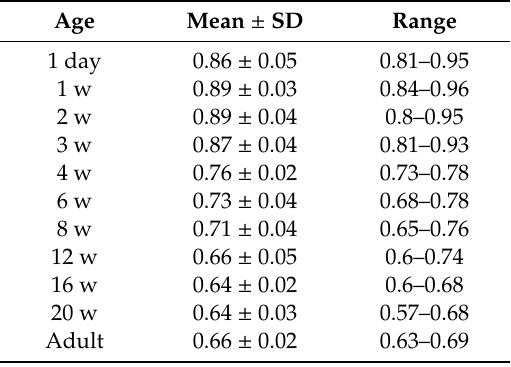
Table 1. Renal resistive index values obtained at di ff erent ages of puppies and adult dogs.